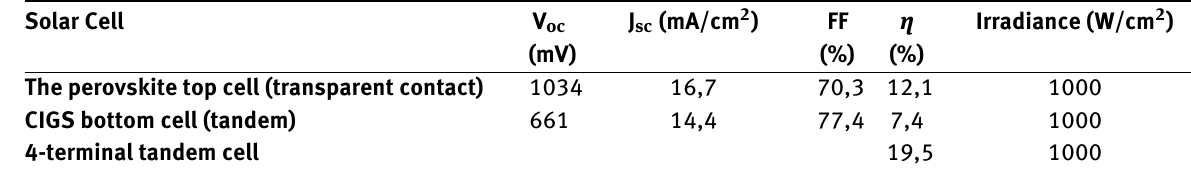
Table 3: The performances and eflciencies of the sub-cells, as well as the eflciency of the 4-terminal tandem cell [51]. Solar Cell The perovskite top cell (transparent contact)